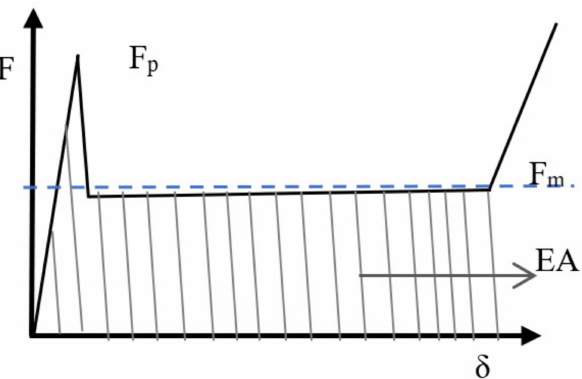
Figure 6. Force–displacement curve of energy-absorbing element in ideal state. SEA refers to the mass specific energy absorption of the structure: SEA = EA m represents the weight of the structure. F m is the mean crushing force: F m = EA crush peak force. CFE is crush force efficiency: CFE = F m